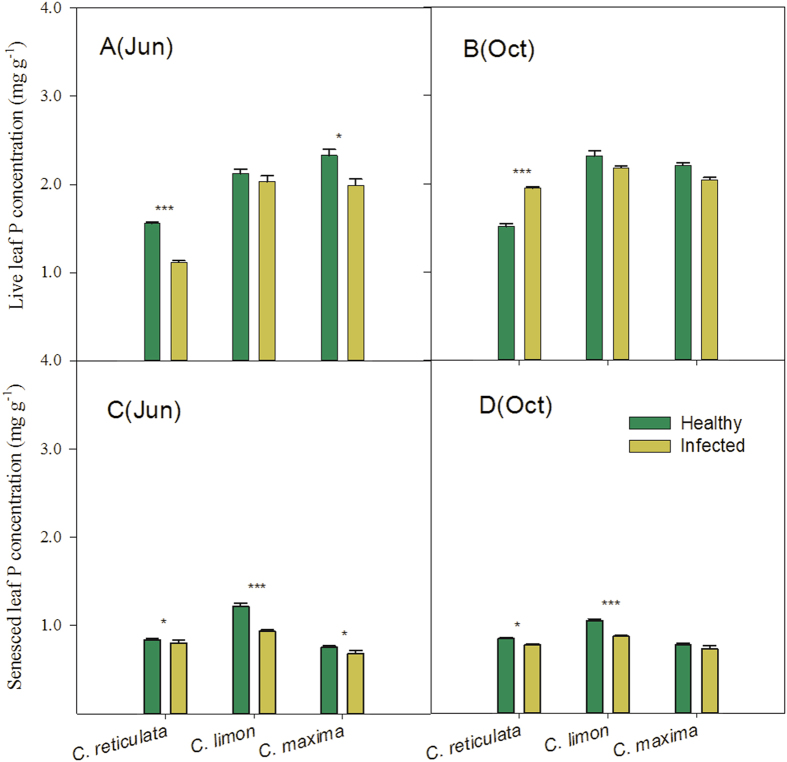
P concentrations in live- and senesced-leaves of different citrus species.Values are mean± Se, n=5. *, ** and *** above bars indicate significant differences at P < 0.05, 0.01 and 0.001, respectively, derived from the results of paired t-tests.